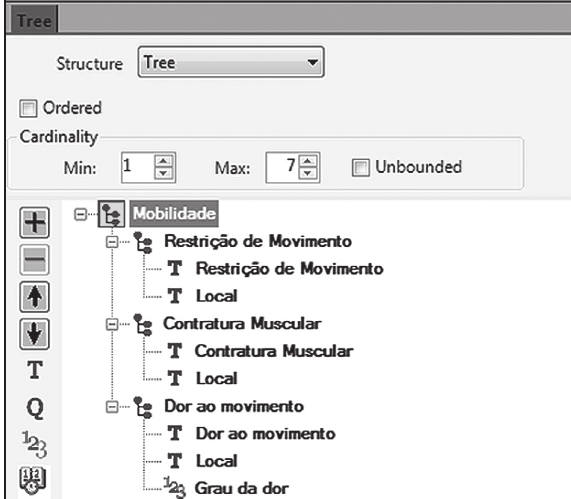
Figura 2 - Arquétipo "Mobilidade" Fonte: Dados da pesquisa.